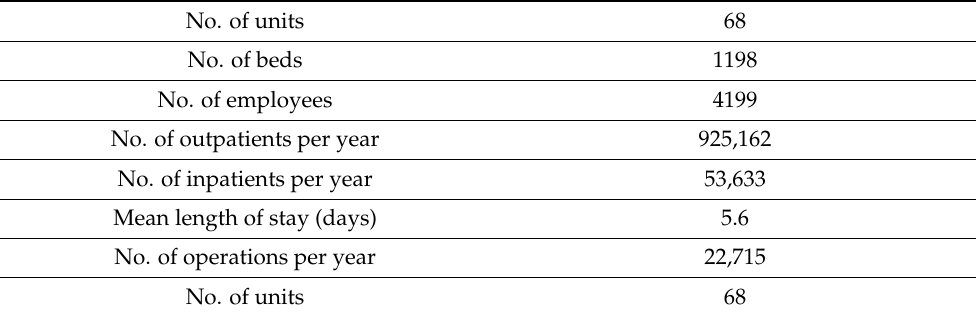
Table 1. Basic information on the University Hospital Olomouc in